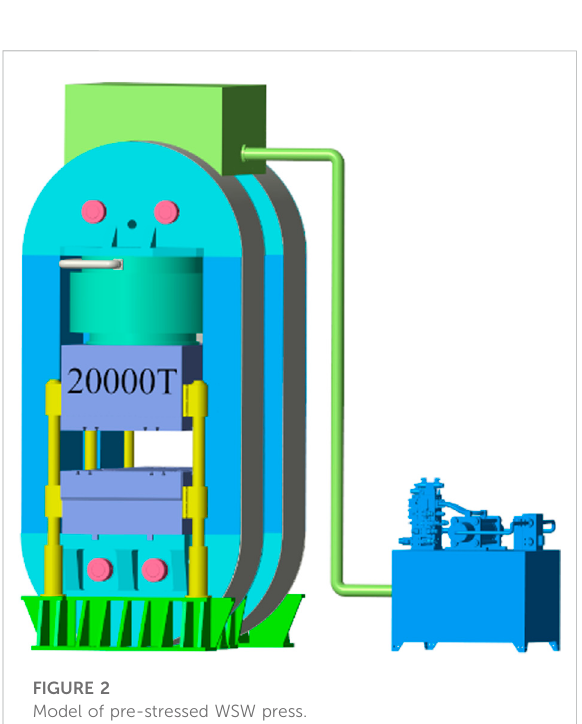
FIGURE 2 Model of pre-stressed WSW